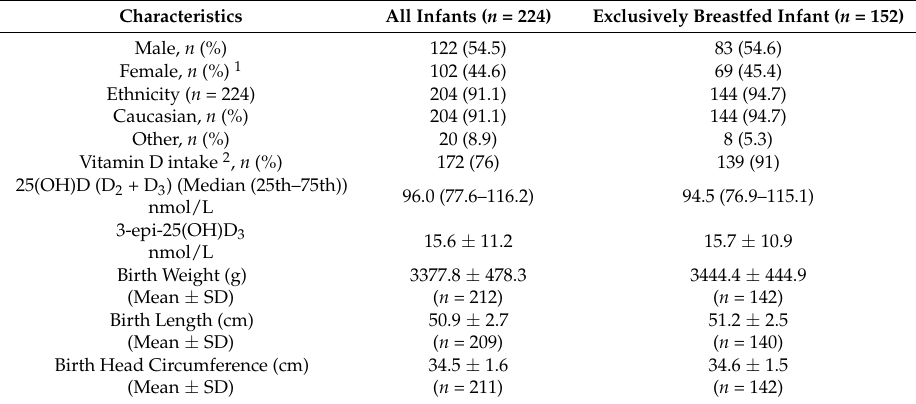
Table 1. Characteristics of